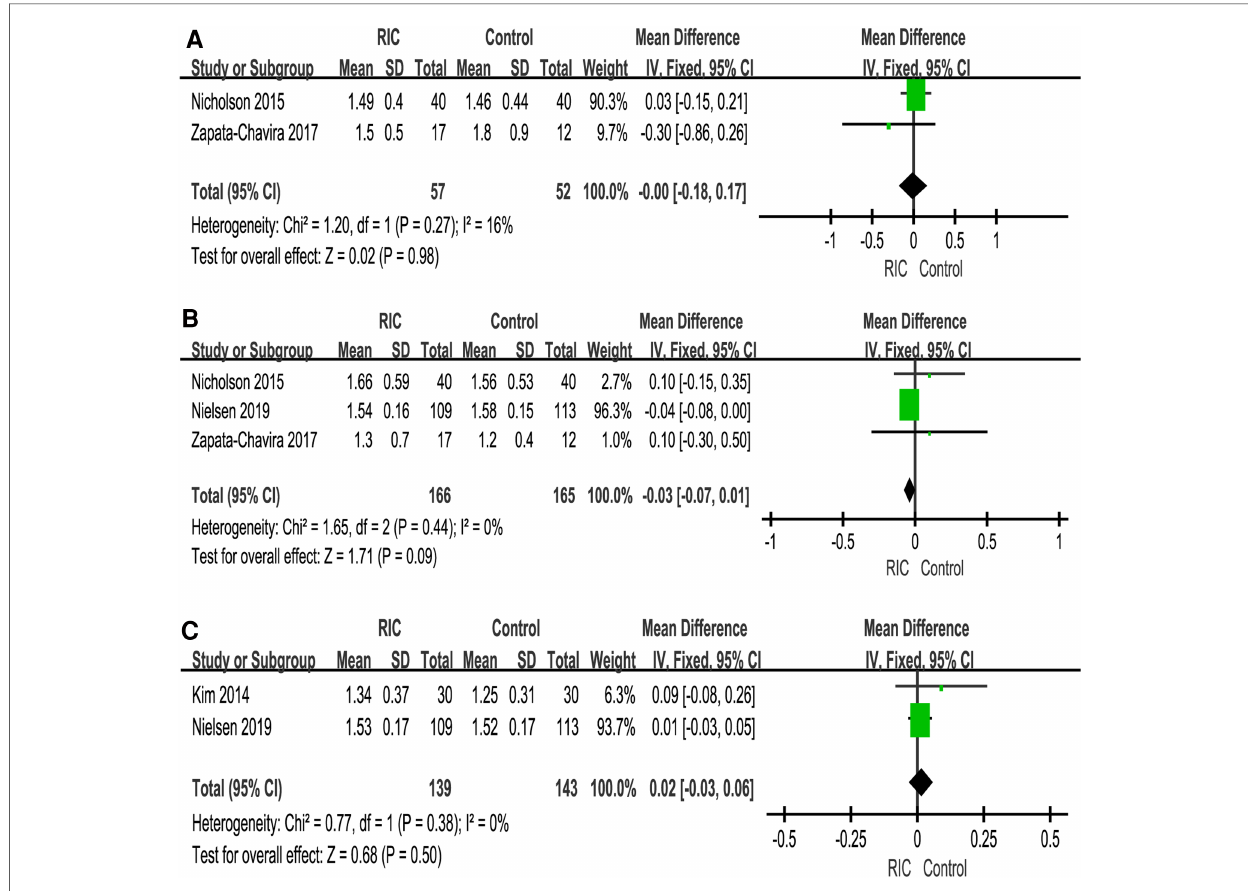
FIGURE 5 Forest plot with 95% con fi dence interval in serum creatinine (Scr), Scr levels at 1 month postoperatively ( A ), Scr levels at 3 months postoperatively ( B ), Scr levels at 12 months postoperatively ( C ). RIC, remote ischemic